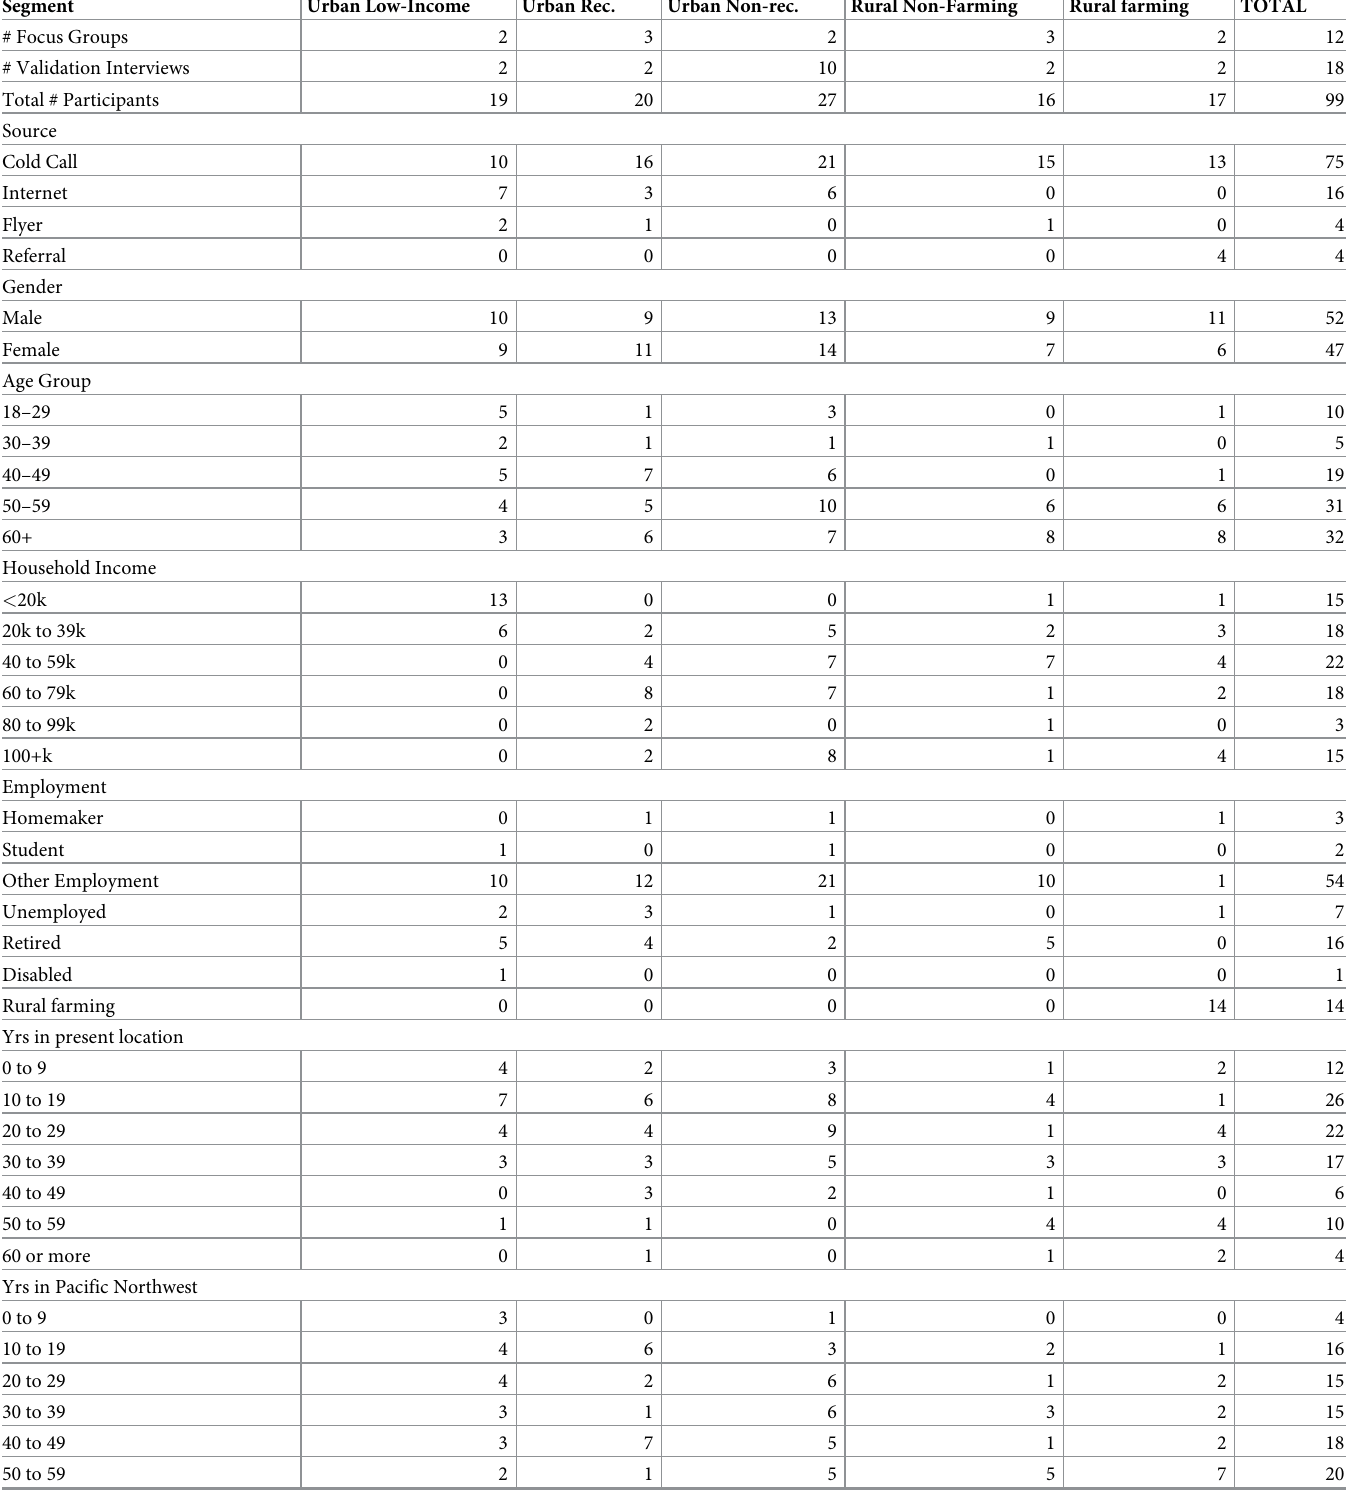
Table 2. Participant sociodemographics 1